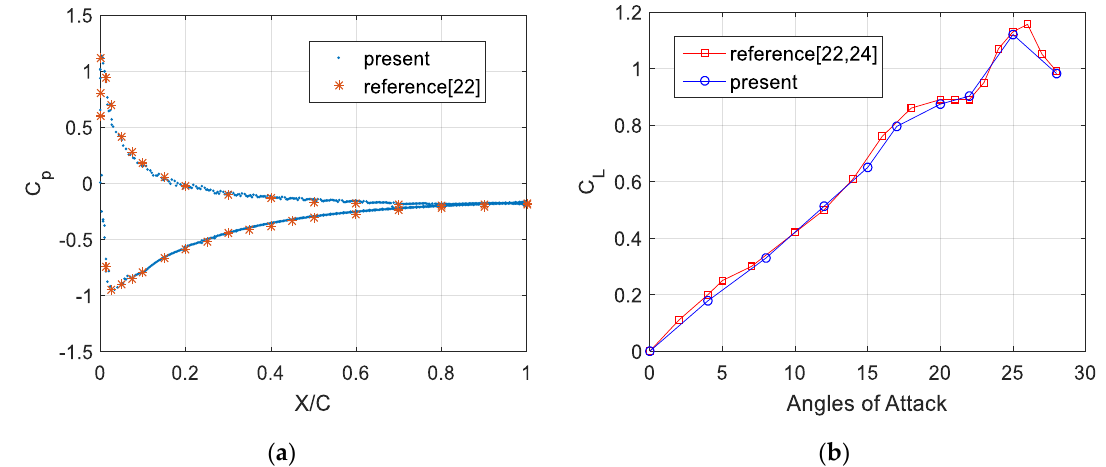
Figure 14. ( a ) Average pressure coe ffi cient ( C p ) distribution at an angle of attack of 8 ◦ ; ( b ) The trend of the lift coe ffi cient ( C L ) with the angle of attack.